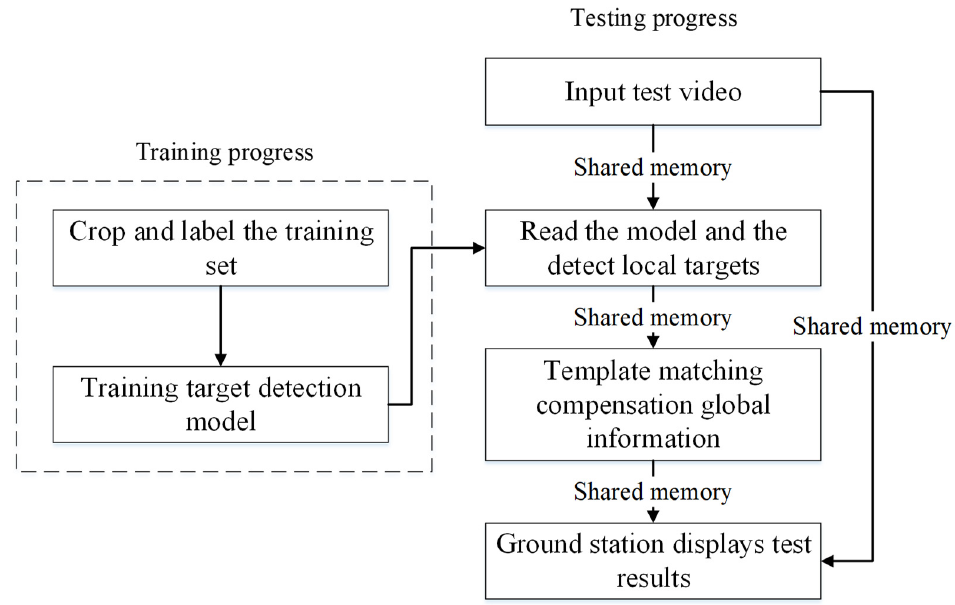
Figure 18. Overall process of verification test for UAV ground station system.